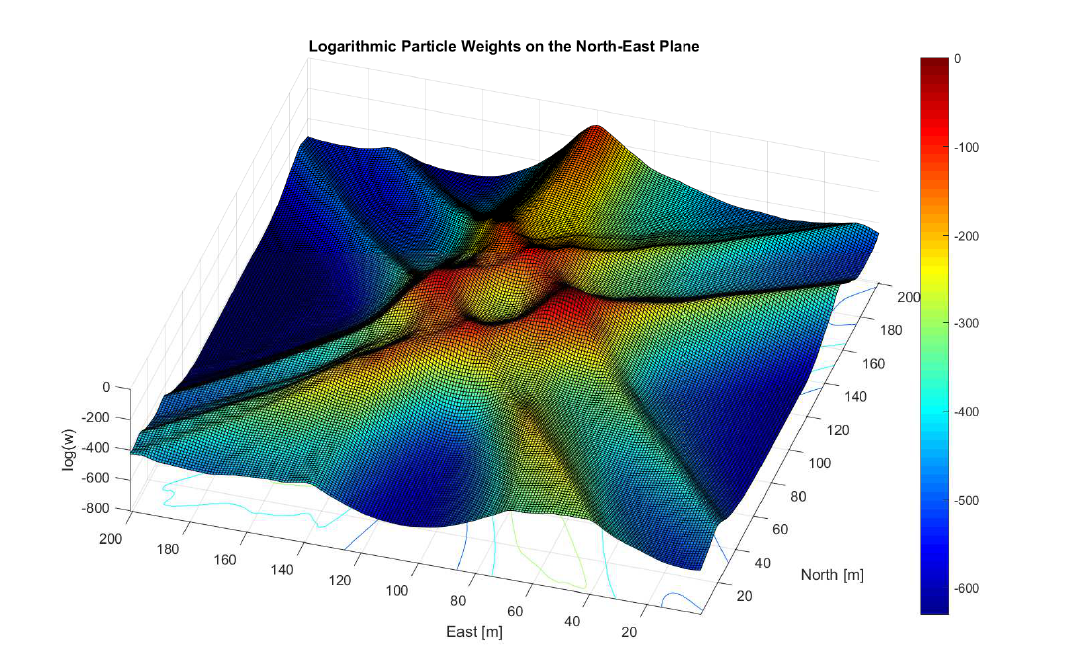
Figure 3. This plot depicts a case when clock error is improperly aligned. The GNSS signals do not overlap at a distinct position in the northeast plane. The plot shows the normalized logarithmic particle weights (cid:101) w i from Equation (35), assuming a uniform distribution from the previous epoch, i.e., k i = 0 and using the optimal particle weight from Equation (34). The particles are equidistantly (cid:101) w k − 1 distributed over a grid. The lines through the plot correspond to the weighted correlation function in the position domain and thus refer to a distinct GNSS signal. The lines look very broad even after the weight update, which comes from the logarithmic scale given by log ( w i integration time for this plot was set to T coh = 2 ms. The processed data refers to open sky. It was recorded at LAT = 47.06446263 deg, LON = 15.40777110 deg on the rooftop of Reininghausstraße